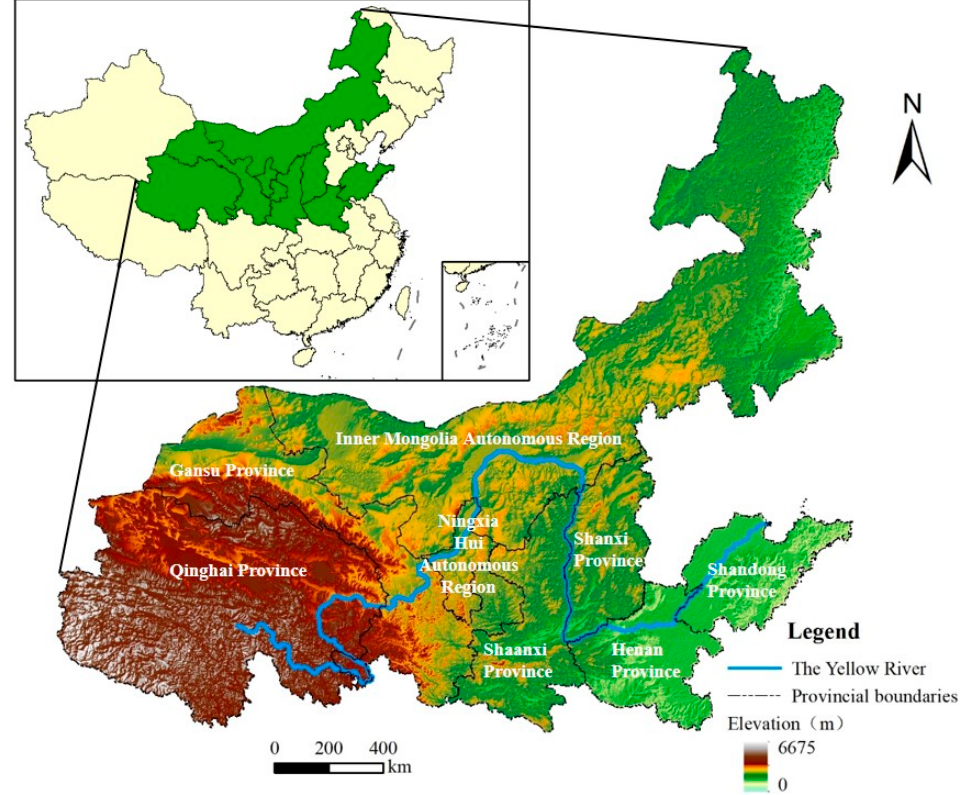
Figure 1. The location of the YRB.